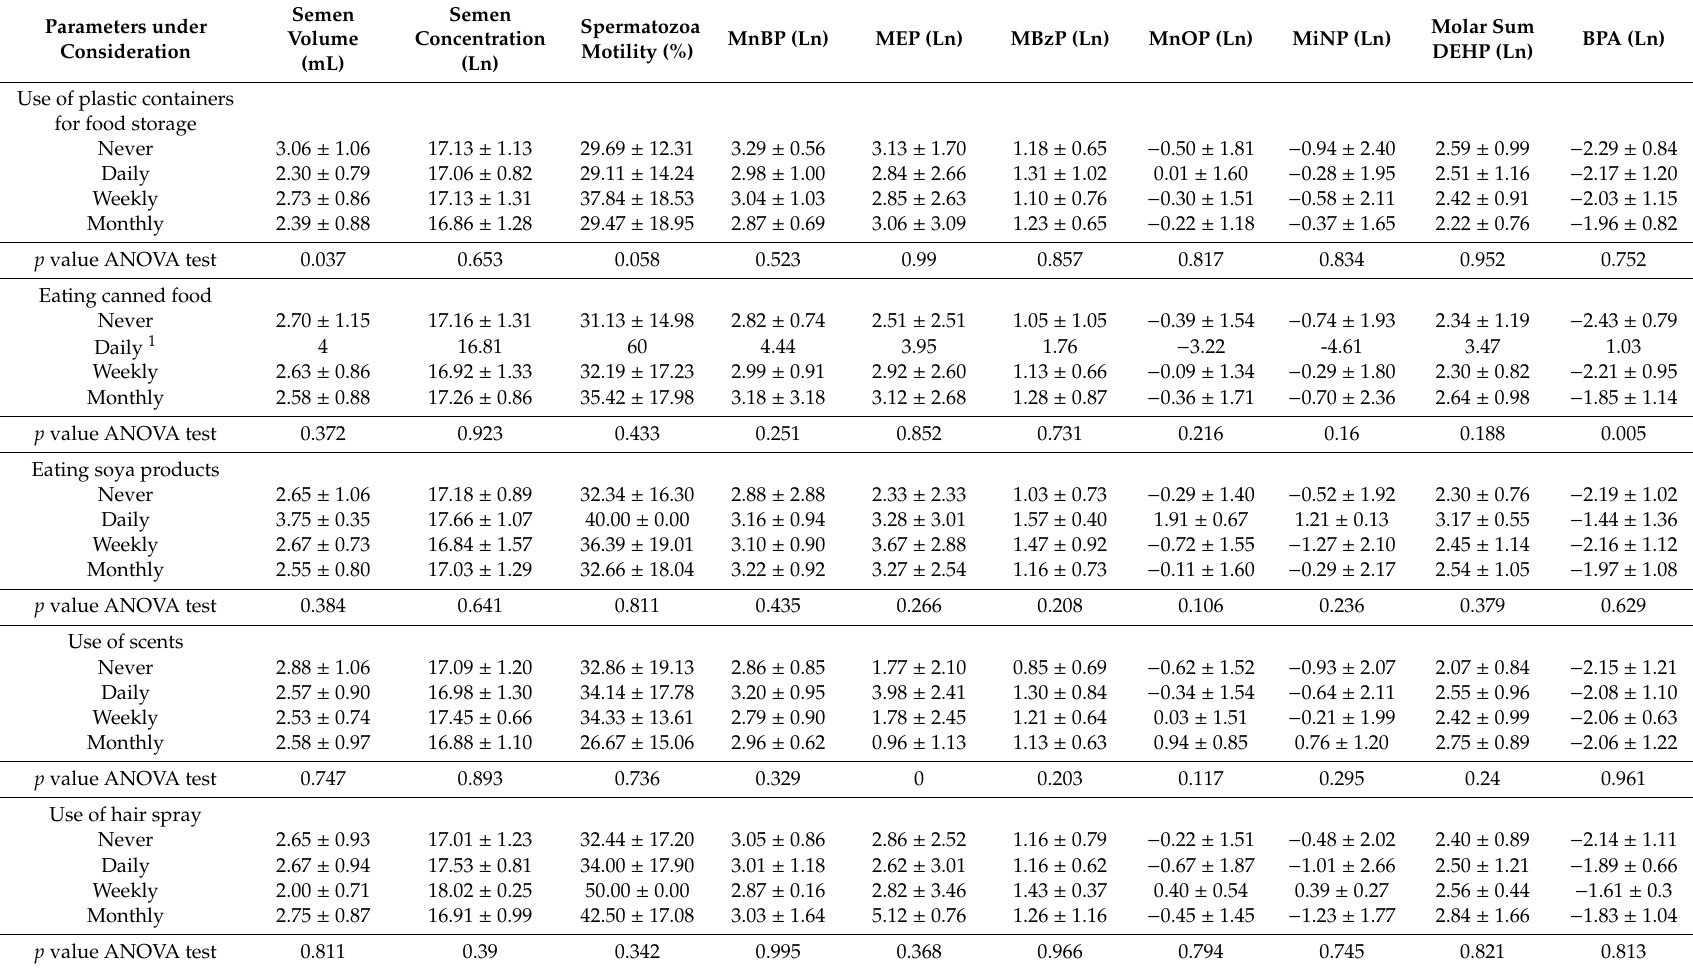
Table 6. Data stratification for food / life habits (mean values with standard